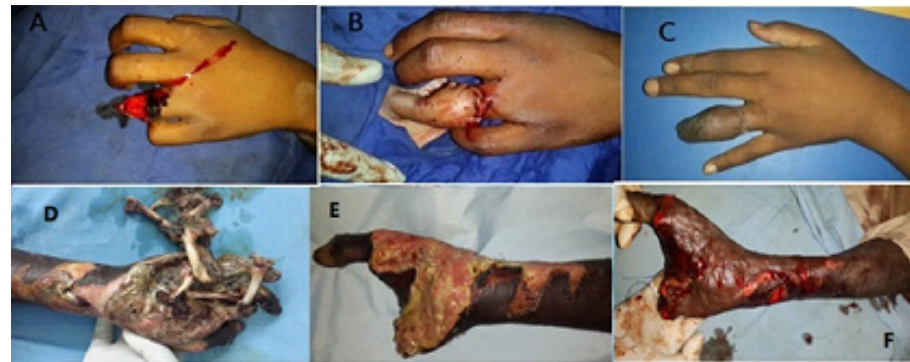
Figure 1 : Hand trauma: A, B, and C show the finger tip degolving injury. D, E, and F prsent the neglected hand burn.